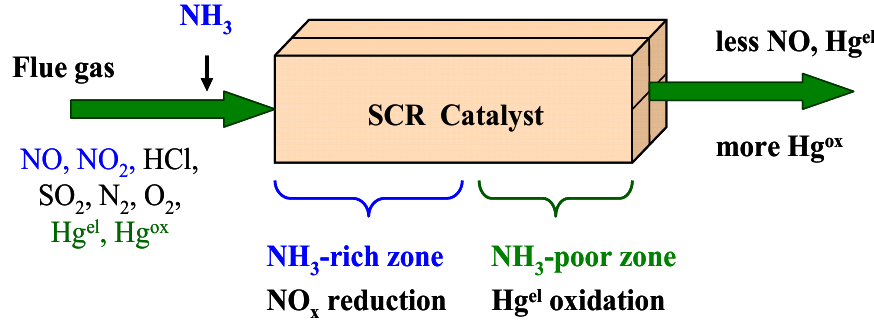
Figure 2. Schematic of Nitrogen Oxides Reduction and Mercury Oxidation over a SCR Catalyst (adapted from